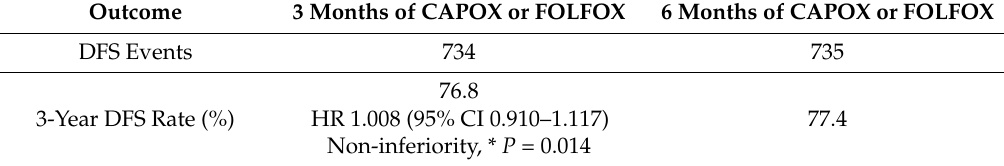
Table 11. Results of a phase III clinical study to investigate the efficacy of 3 months vs. 6 months of adjuvant chemotherapy in surgically resected stage III or high-risk stage II colorectal carcinoma.